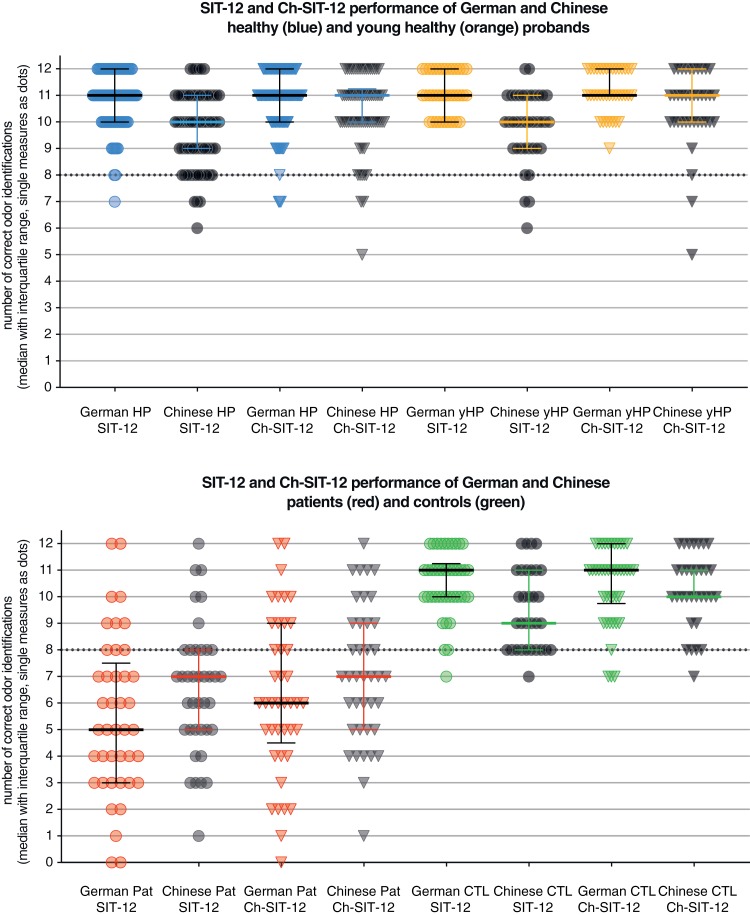
Numbers of correct odor identifications as median with interquantile range and single measures as dots for all tested cohorts and subgroups as well as both tested Sniffin’ Stick sets (SIT-12 = original German version; Ch-SIT-12 = adapted Chinese version).Blue = all healthy subjects (HP); Orange = subgrop of young (20–40 years old) healthy subjects (yHP); Red = all patients (Pat), Green = age matched subgroup of healthy subjects as control group for patients (CTL).